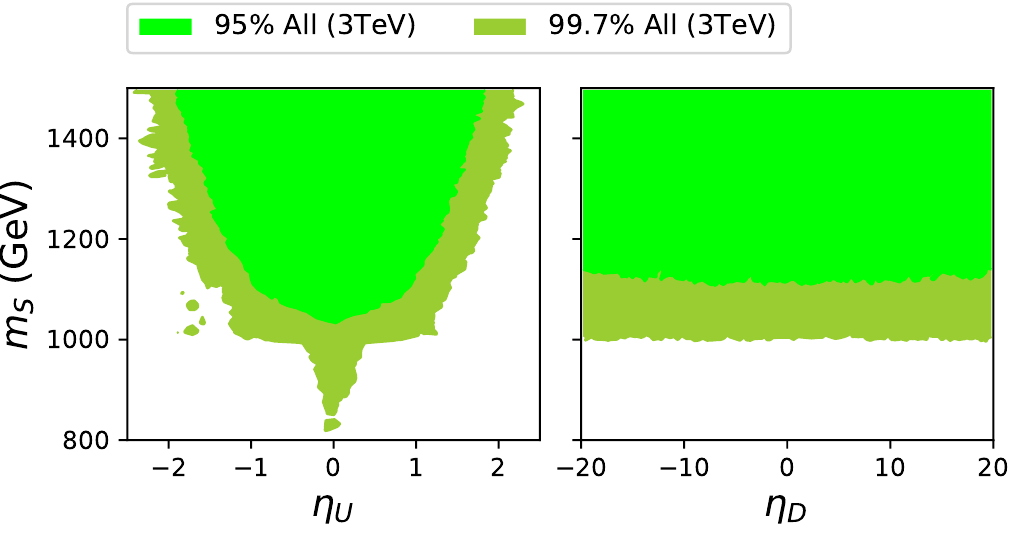
Figure 7 . Allowed regions on the m S - η U (left) and m S - η D (right) planes from the global fit, at 95% and 99.7% probability, imposing RG stability up to 3 TeV and perturbative unitarity at NLO+. Quite similar results are obtained, requiring RG stability up to only 1